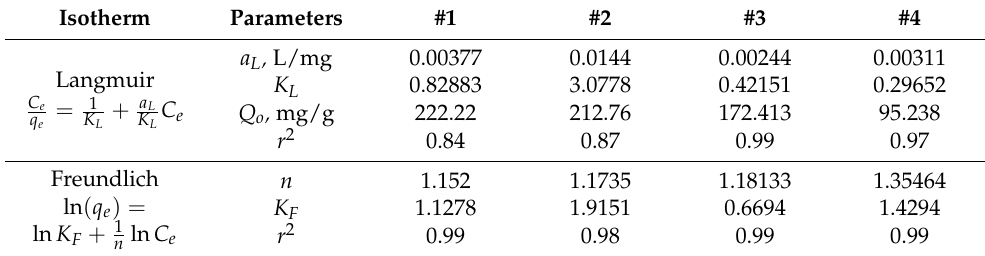
Table 2. Isotherm equilibrium model parameters of Langmuir and Freundlich isotherm for Flytek